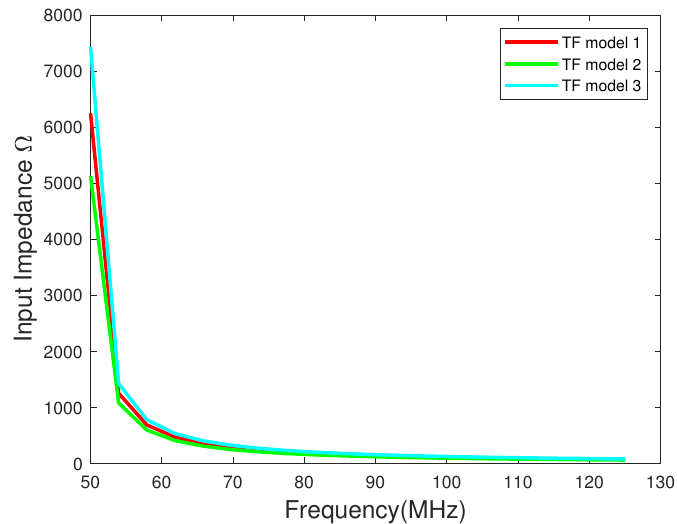
Figure 19. Input impedance of two-fold (TF) antenna models with respect to frequency calculated numerically. TF models 4 will show similar characteristic impedance as TF model 1. Here we have modeled the two fold antenna as two single-fold antennas in